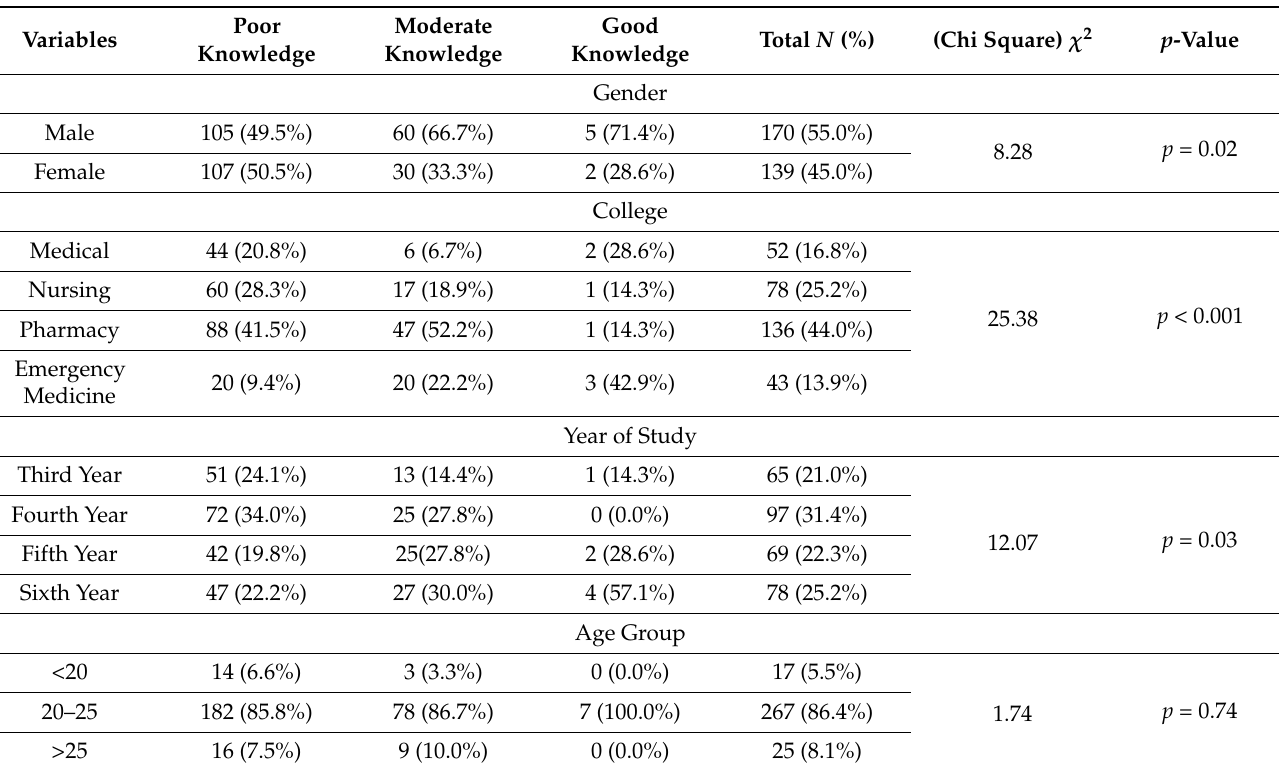
Table 5. Cross-tabulations between the participants’ demographics and the knowledge